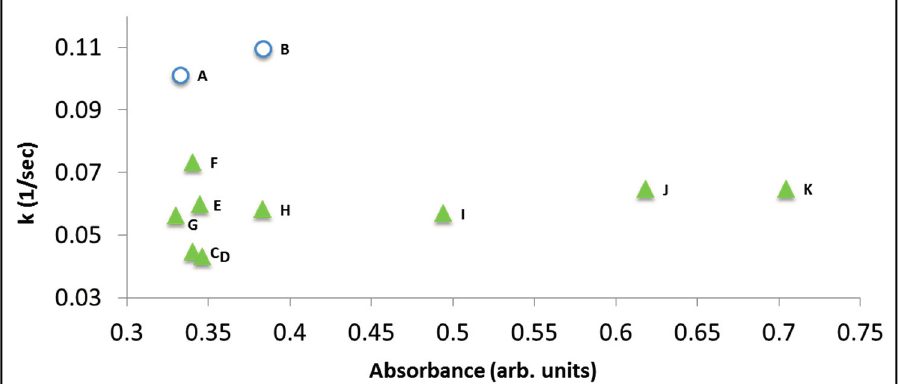
Figure 6. The decolorization rate constant versus relative absorption of RhB on the surface of BiOCl. Each point represents exposure to light of different wavelength (but same photon flux). The nominal concentration of the dye was 6 mg/L. (A) 365 nm; (B) 375 nm; (C) 395 nm; (D) 405 nm; (E) 410 nm; (F) 420 nm; (G) 435 nm; (H) 470 nm; (I) 490 nm; (J) 505 nm; (K) 515